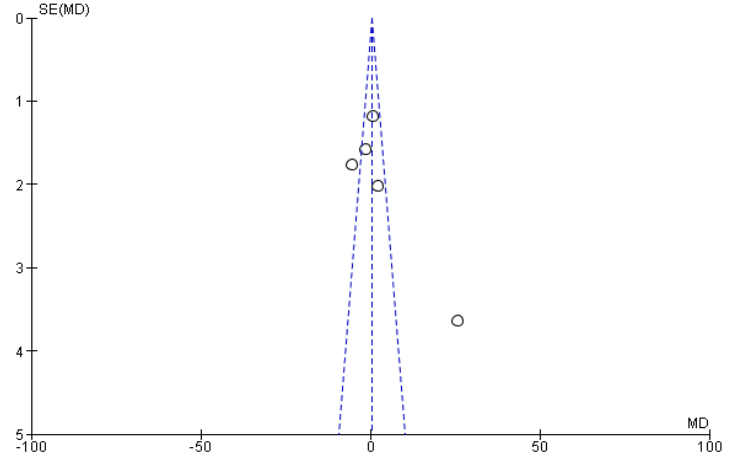
Figure 6. Forest plot for extraction and non-extraction.